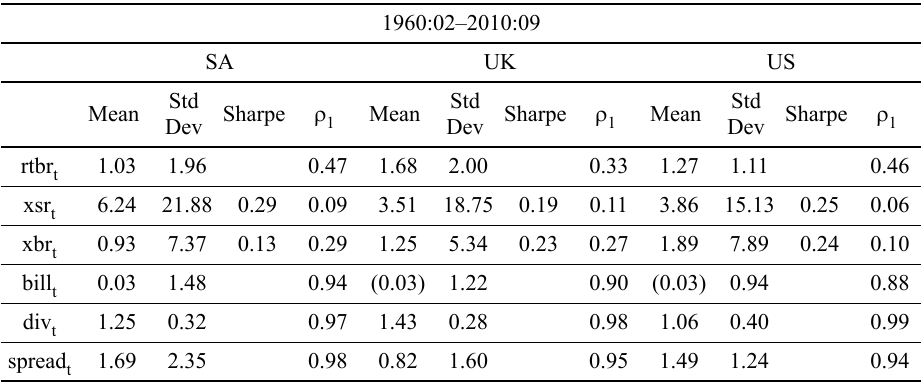
Table 1. Summary statistics for the full sampling